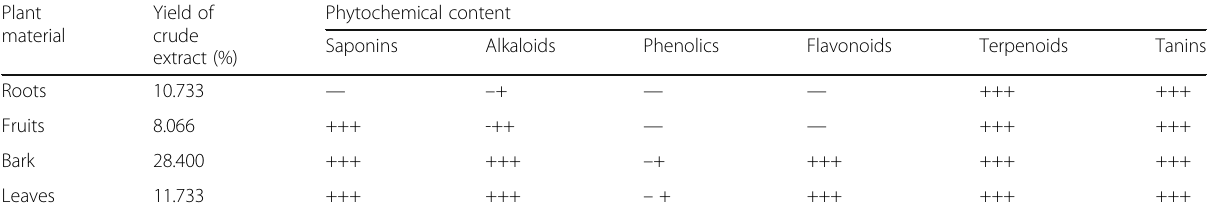
Table 1 Percentage yield of extraction and phytochemical composition of different extracts Plant